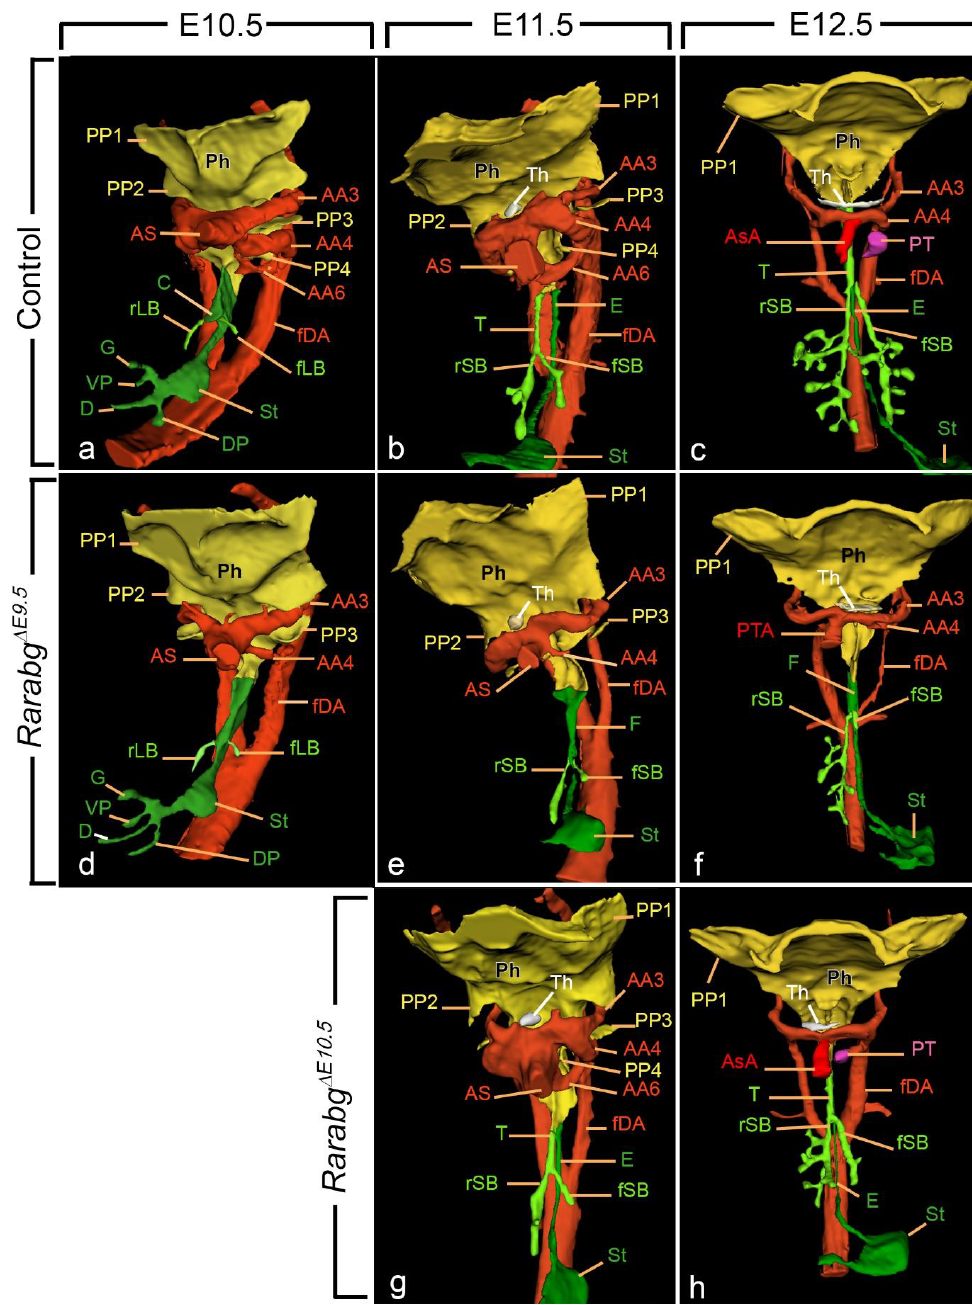
Figure 3. Left latero-ventral views ( a , b , d , e , g ) and ventral views ( c , f , h ) of 3D-reconstructions of the pharyngeal and foregut regions in control embryos ( a – c ), Rarabg ∆ E9.5 mutants ( d – f ) and Rarabg ∆ 10.5 mutants ( g , h ) at E10.5, E11.5, and E12.5, as indicated. AA3, AA4, and AA6, 3rd, 4th, and 6th aortic arches; AS, aortic sac; AsA, ascending aorta, C, presumptive carina; D, duodenum; fDA, left dorsal aorta; DP, dorsal pancreatic bud; E, esophagus F, (undivided) foregut tube; G, gallbladder; rLB and fLB, lumens of the right and left lung buds, respectively; Ph, pharyngeal cavity; PP1, PP2, PP3, and PP4, 1st, 2nd, 3rd, and 4th pharyngeal pouches; PT, pulmonary trunk; PTA, persistent truncus arteriosus; rSB and fSB, right and left stem bronchi, respectively; St, stomach; T, trachea; Th, thyroid gland; VP, ventral pancreatic bud. Same magnifications in ( a , d ), in ( b , e , g ) and in ( c , f , h ).